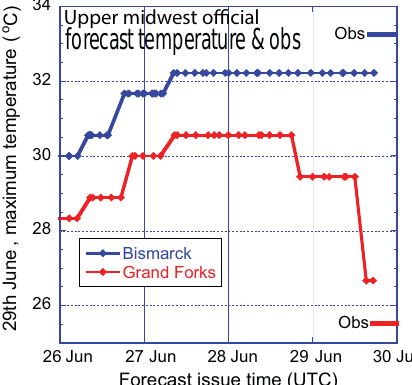
Figure 6. The forecasted daily maximum temperatures from Grand Forks and Bismarck National Weather Service offices as a function of forecasting hours. Short lines on the top and bottom of the right- hand side of the figure represent observed daily maximum temper- atures for the two stations on 29 June